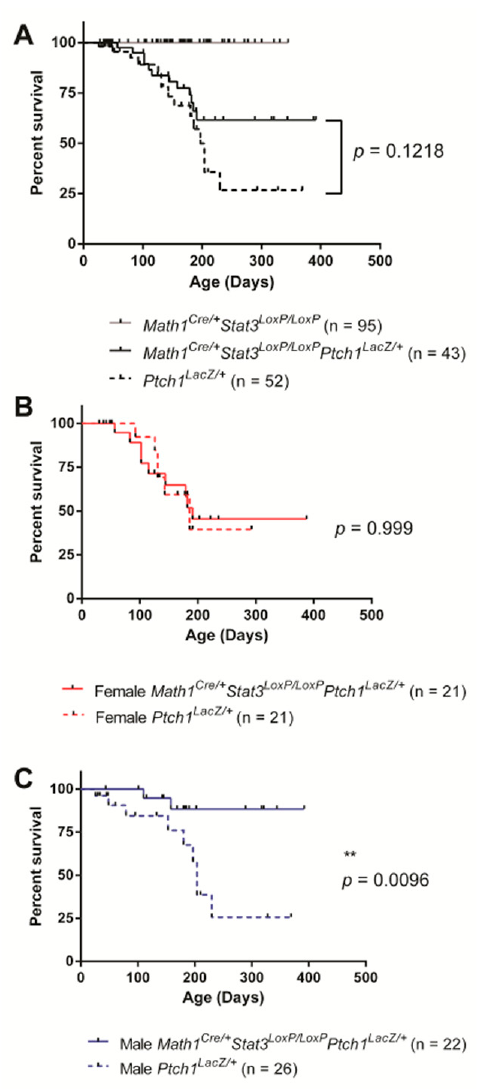
Figure2. Stat3deletionimprovedsurvivalofmalemiceinthePtch1 LacZ /+ modelofSHHMB.( A Figure 2. Stat3 deletion improved survival of male mice in the Ptch1 LacZ/+ model of SHH MB. ( A ) Kaplan-Meier survival analysis of male and female mice. Ptch1 LacZ/+ mice (n = 52) and Math1 Cre Stat3 LoxP/LoxP Ptch1 LacZ/+ (n = 43) showed similar disease onset and overall survival ( p = 0.1218).